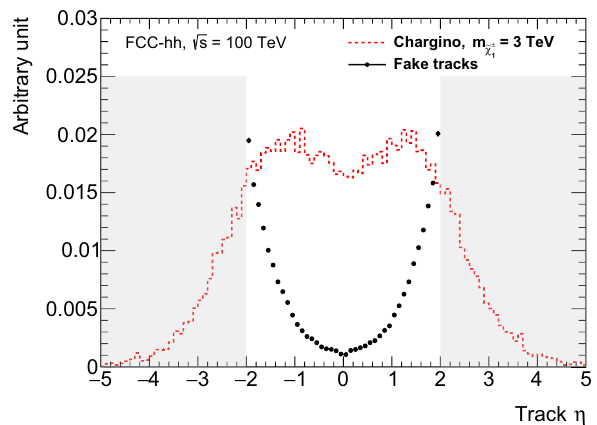
Fig. 3 η distributions of fake tracks in minimum-bias collision events and chargino tracks in 3 TeV wino signal events. The normalization is arbitrary. The details of fake track reconstruction is described in Sect. 5.2. The fake-track distribution is shown only within the range | η | <